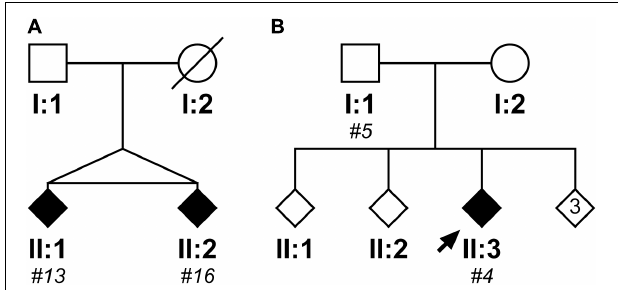
FIGURE 5 | Pedigrees of two case reports from the SCA17 cloned patient cohort. The first family shows two monozygotic twins (II:1, subject #13; II:2, subject #16), who have a clone sequenced mean pathogenic allele size of 47 repeats and mean normal alleles of 38 and 37 repeats, respectively (A) . Subject #13 (II:1) presented with a more severe phenotype compared to their sibling, with an age of onset 3 years prior and dementia/cognitive impairment and chorea in addition to the ataxia observed in their sibling (Subject #16, II:2). The second family shows a father (I:1, subject #5) and child (II:3; subject #4) where the father was asymptomatic at the age of 50 years old, whilst the child developed ataxic symptoms at the age of 21 years old (B) . Despite the apparent anticipation, they both had a clone sequenced mean pathogenic allele size of 51 repeats, but their normal alleles differed with the child having a slightly larger mean allele size of 39 repeats compared to 37 repeats in their father. DNA was only available for individuals who were cloned, with the given subject number in